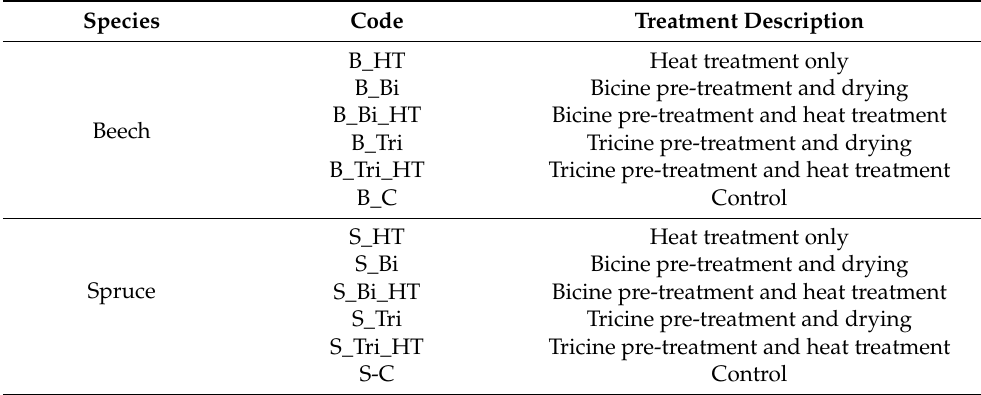
Table 1. Overview of treatments